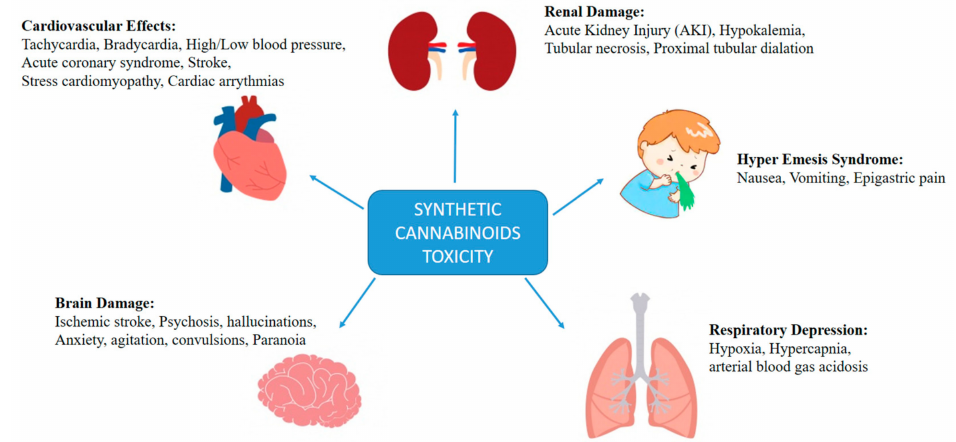
Figure 3. Toxicity of synthetic cannabinoids and their adverse